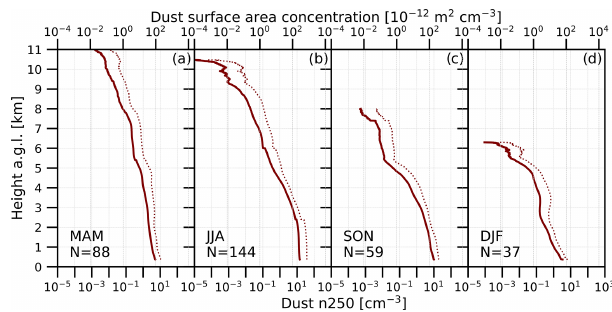
Figure 16. Same as Fig. 12 except for the seasonal mean dust parti- cle number concentration n 250 , d (considering particles with radius > 250nm) and dust surface area concentration.